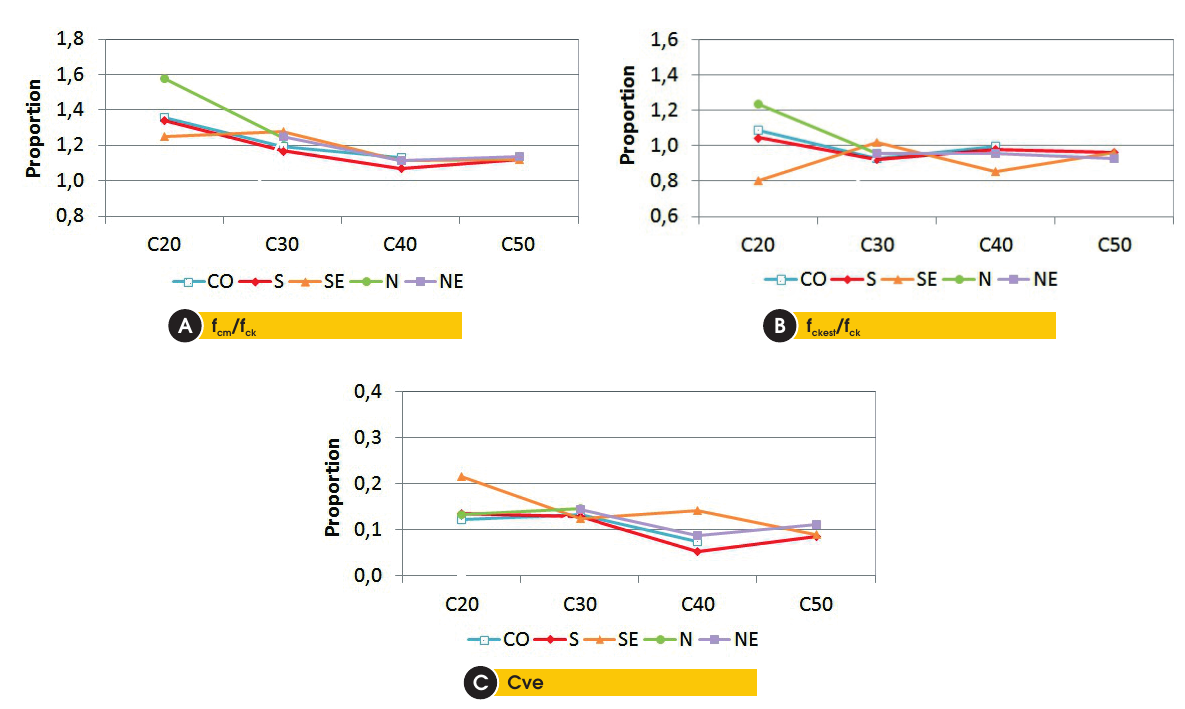
Summary of the results of concrete produced in the different regions of the country